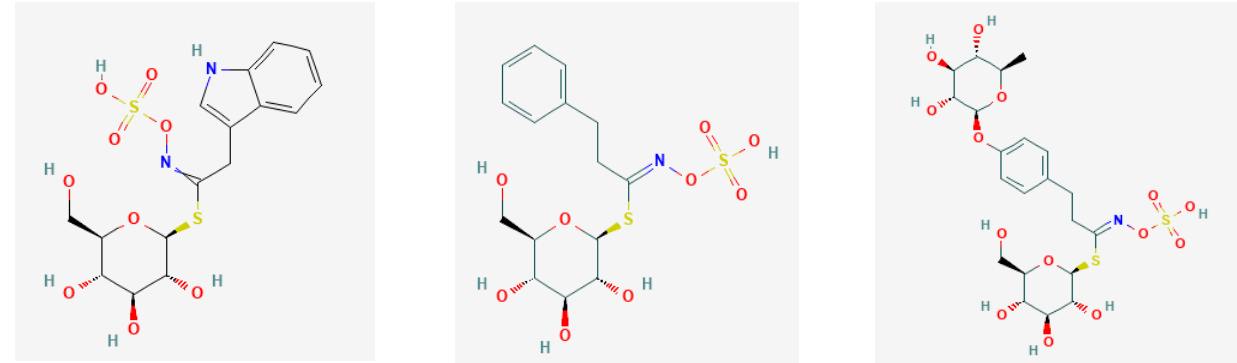
Figure 3. Chemical structures of glucoerucin (PubChem Identifier: CID 656539; https://pubchem. ncbi.nlm.nih.gov/compound/656539) and glucoraphanin (PubChem Identifier: CID 9548634; https: //pubchem.ncbi.nlm.nih.gov/compound/9548634), respectively, from PubChem [27].